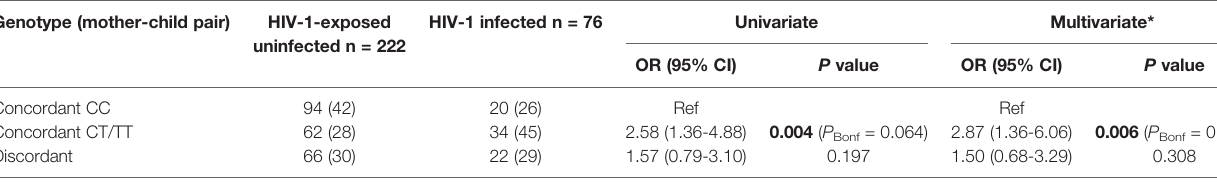
TABLE 6 | Mother-child FCGR2C c.134-96C>T genetic similarity and HIV-1 acquisition a . Genotype (mother-child